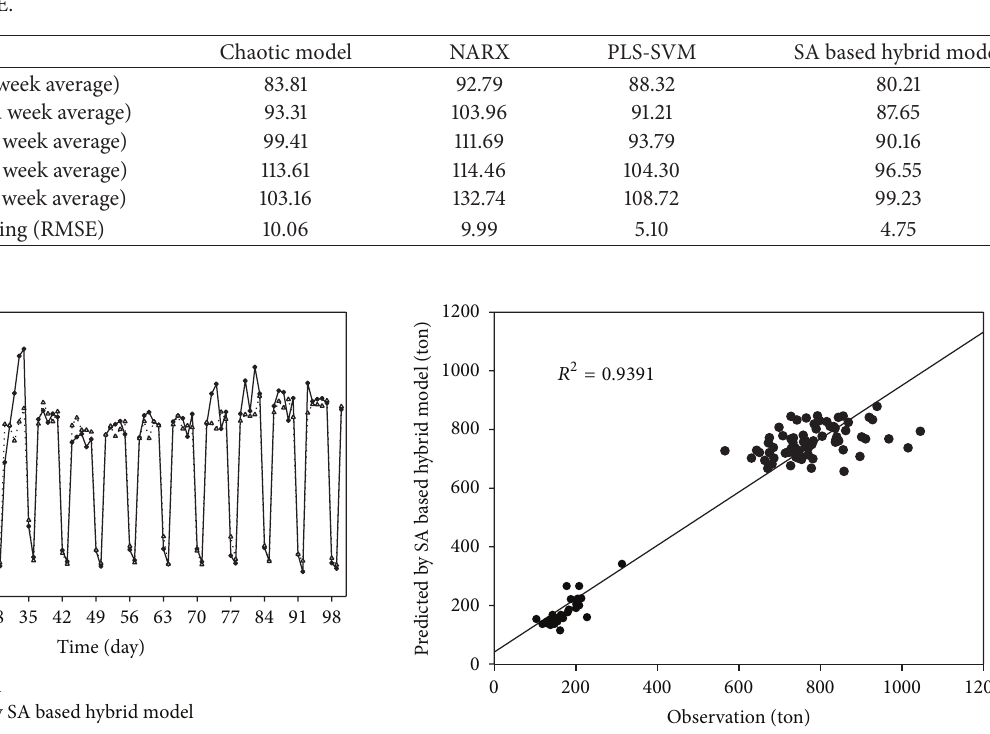
Figure4: 𝑅 2 ofobservationandSAbasedhybridforecastofonestep ahead prediction. Time span covers the last 100